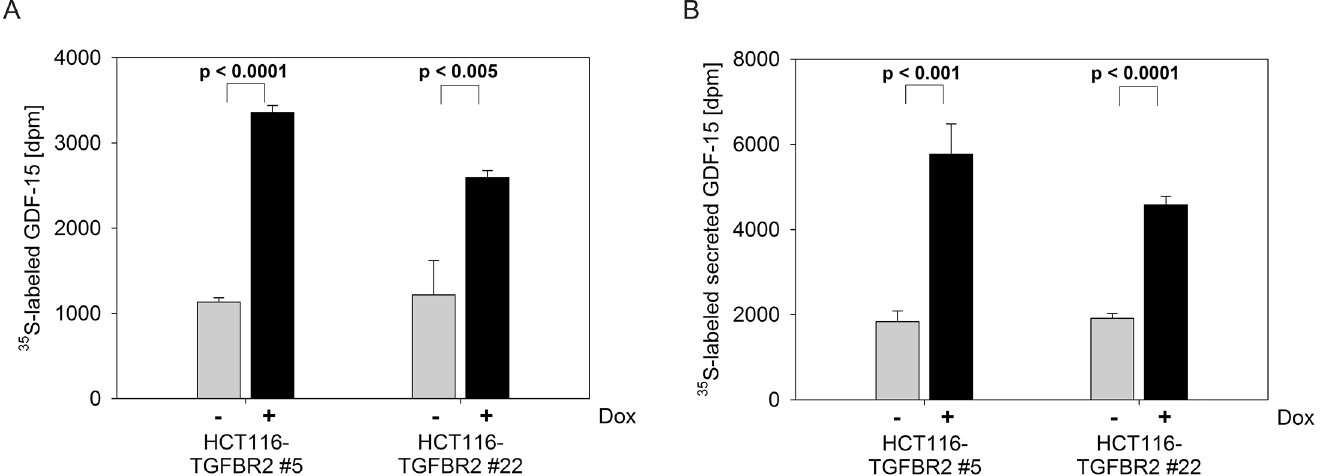
Fig 2. Radioactive labeling experiments. [ 35 S]-L-methionine was used for metabolic labeling and subsequent immunoprecipitation of intracellular GDF-15 from total lysates (A) or secreted GDF-15 from cell culture medium (B). Cells were stimulated with TGF-ß1 for 4 h in (A) and 24 h in (B).